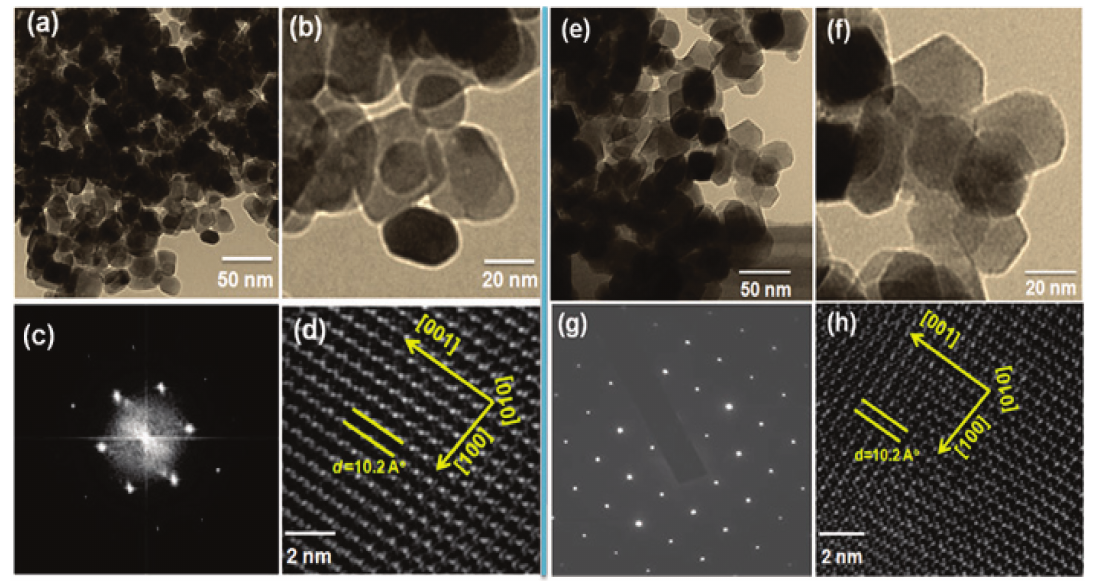
H CoO 4H O as starting 4 6 4 2